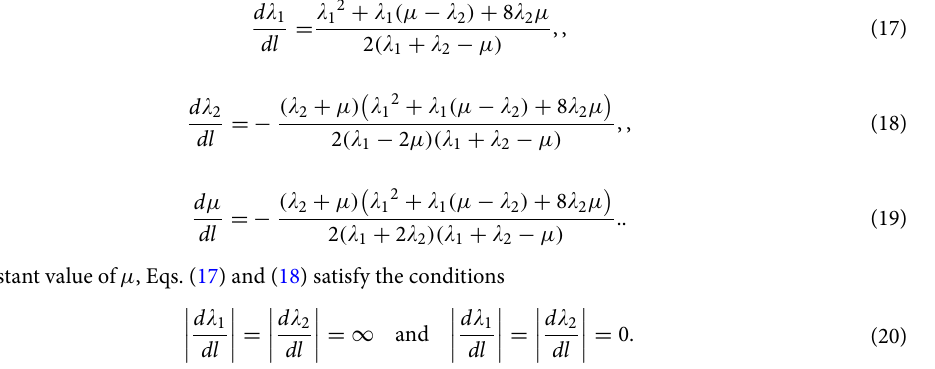
For a constant value of µ , Eqs. (17) and (18) satisfy the conditions